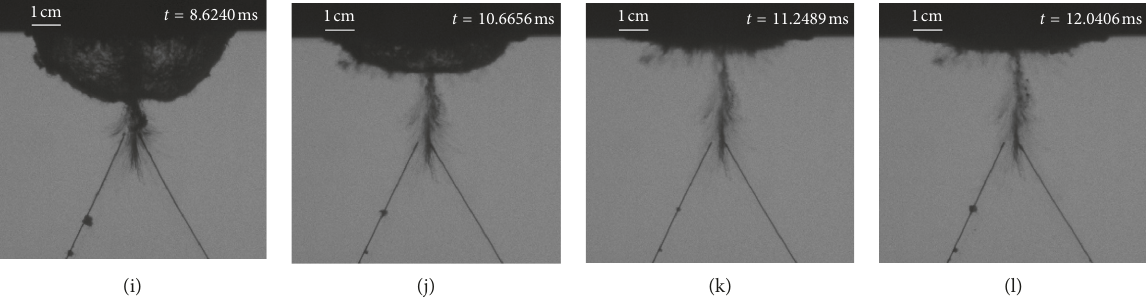
Figure 14: Evolution of the first cycle of the underwater spark-generated bubble’s expansion and collapse below the target plate with 40mm standoff. (a) t � 0.0406ms. (b) t � 0.7490ms. (c) t � 0.8740ms. (d) t � 3.1656ms. (e) t � 5.9156ms. (f) t � 6.2073ms. (g) t � 6.2490ms. (h) t � 6.8323ms. (i) t � 8.6240ms. (j) t � 10.6656 ms. (k) t � 11.2489ms. (l) t � 12.0406